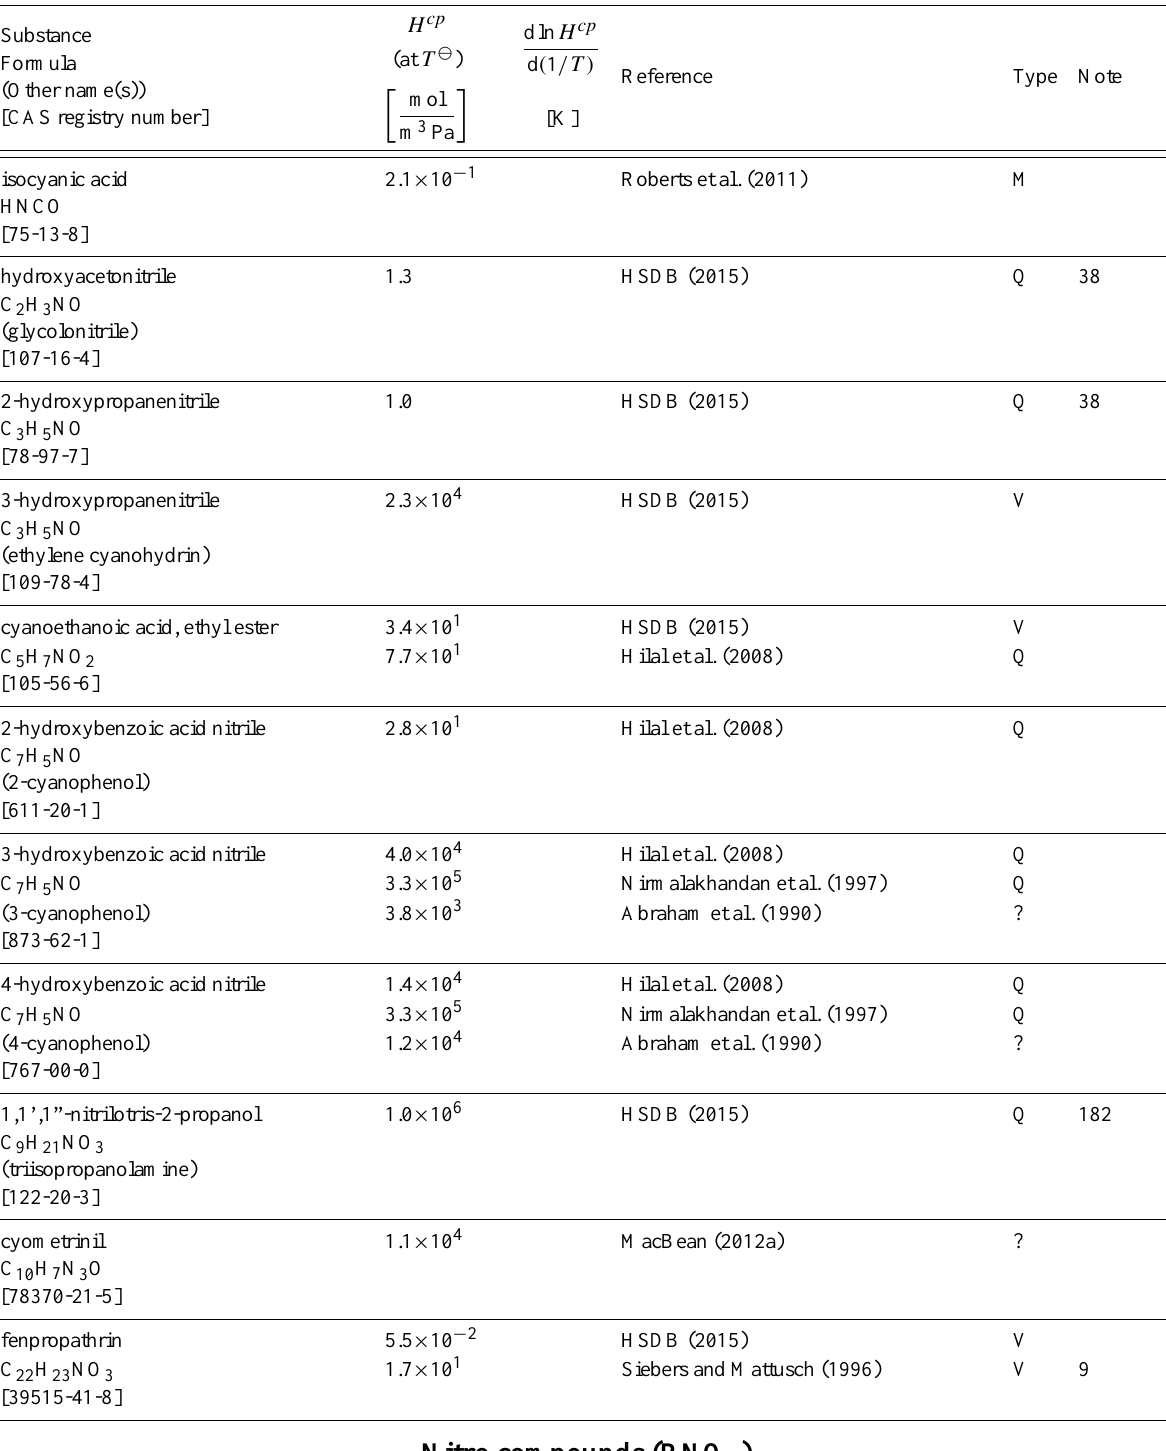
Table 6: Henry’s law constants for water as solvent